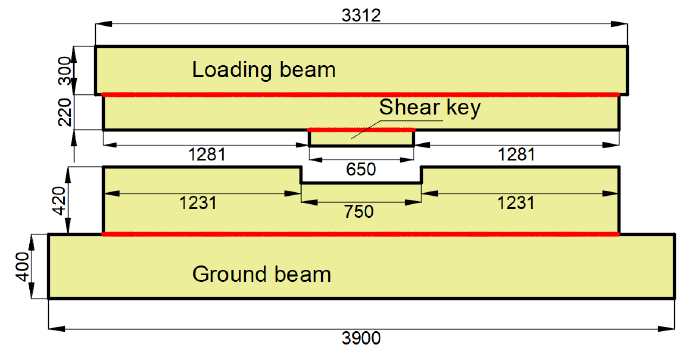
Figure 4. Elevation diagram of immersion joint model.